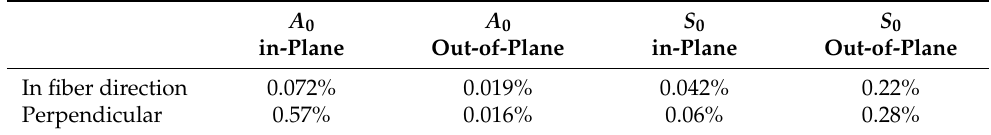
Table 4. Calculated mean error for the 2D model at 120kHz.